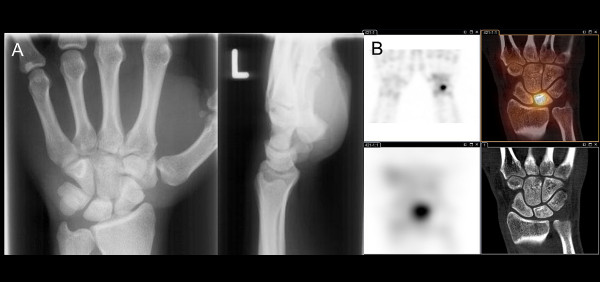
A 25-year-old male with left-sided wrist pain when grabbing and lifting. Tendinitis was suspected. (A) Plain radiographs showed no bone lesion. (B) SPECT/CT revealed an intense radioisotope uptake in the lunate bone corresponding with osteomalacia of the lunate bone followed by surgery (top row: three-dimensional (3D)-SPECT and fusion SPECT/CT, bottom row: planar SPECT and CT-alone).